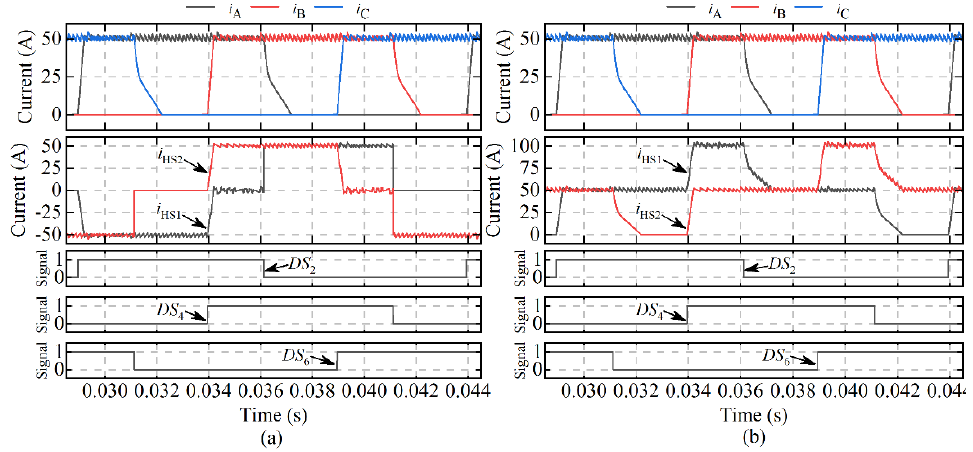
Figure 19. Simulation waveforms at 500 rpm ( i * = 50 A). ( a ) With the proposed N p /2 sensors-based current detection scheme. ( b ) With the baseline scheme.